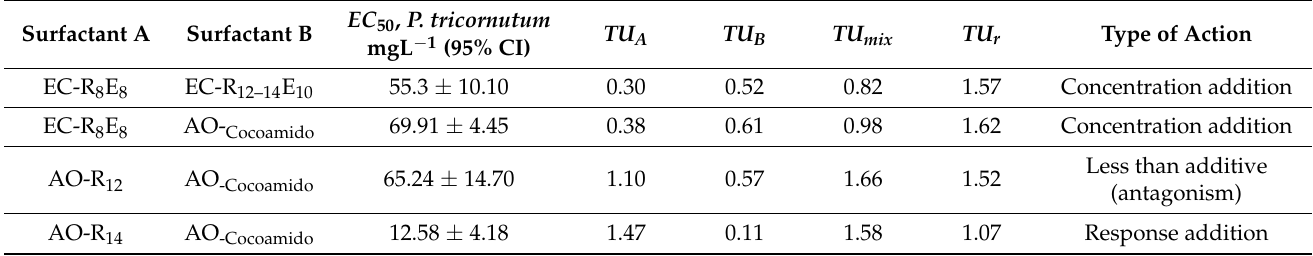
Table 6. Toxicity values and MTU parameters of surfactants mixtures (1:1 w / w ) to marine microalgae P. tricornutum (exposure time: 72